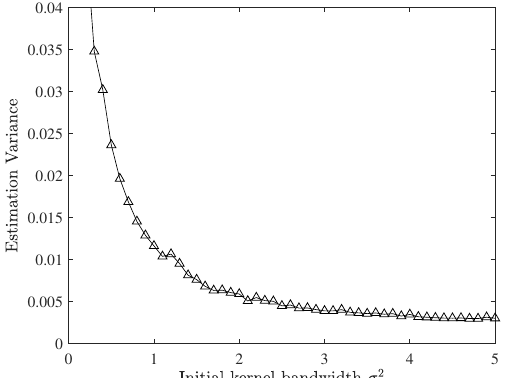
Figure 9. Estimating the variance of the estimate ˆ µ N for various kernel bandwidths σ 2 in the general mean-shift